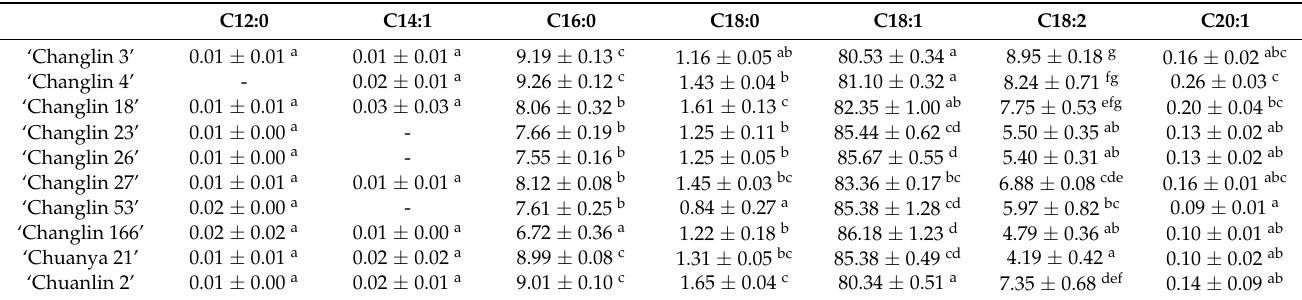
Table 2. Fatty acid composition in C. oleifera oil of ten cultivars